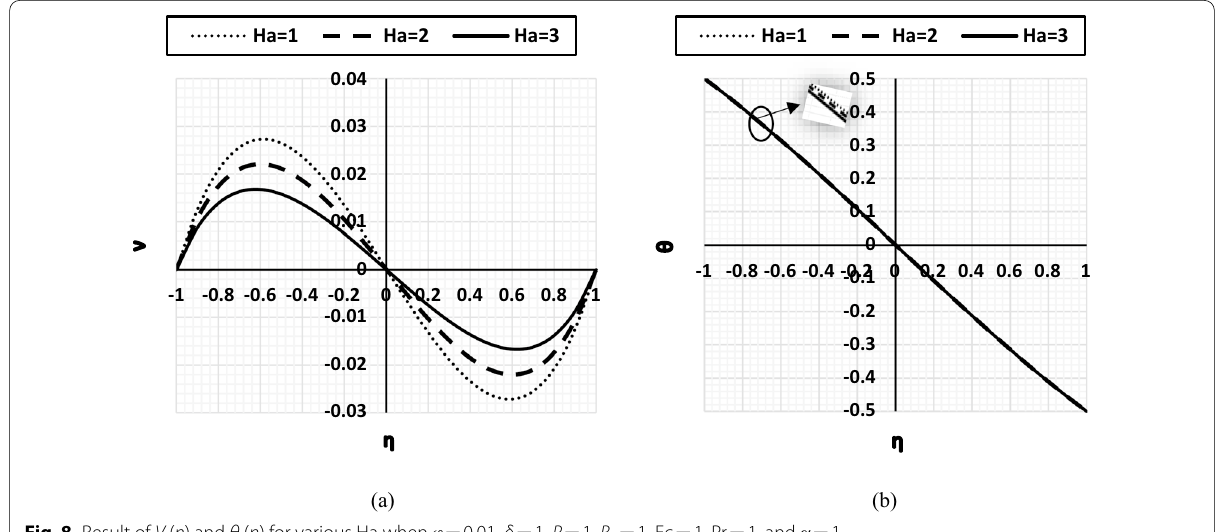
Fig. 8 Result of V ( η ) and θ ( η ) for various Ha when ϕ